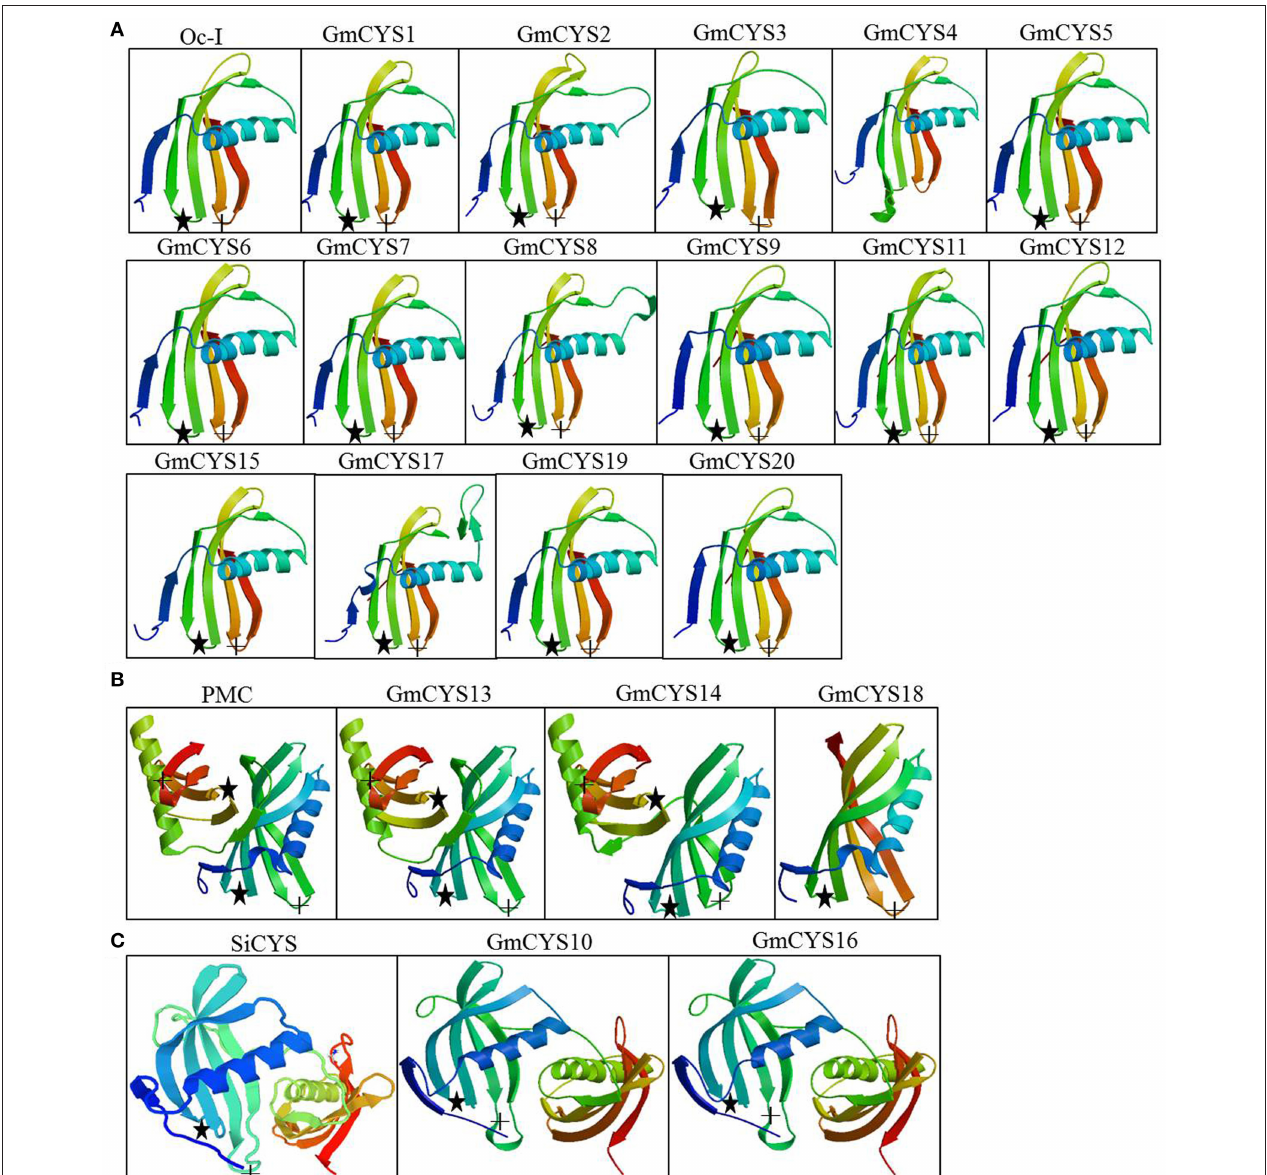
FIGURE 2 | The three-dimensional structure prediction of soybean cystatins. (A) The three-dimensional structures of 15 cystatins were predicted using the automated SWISS-MODEL program with OC-I as a template. (B) The three-dimensional structures of GmCYS13, GmCYS14, and GmCYS18 were predicted using the automated SWISS-MODEL program with PMC as a template. (C) The three-dimensional structures of GmCYS10 and GmCYS16 were predicted using the automated SWISS-MODEL program with SiCYS as a template. Two important motifs involved in the interaction with the target enzymes are indicated the reactive site (asterisks) and W residue